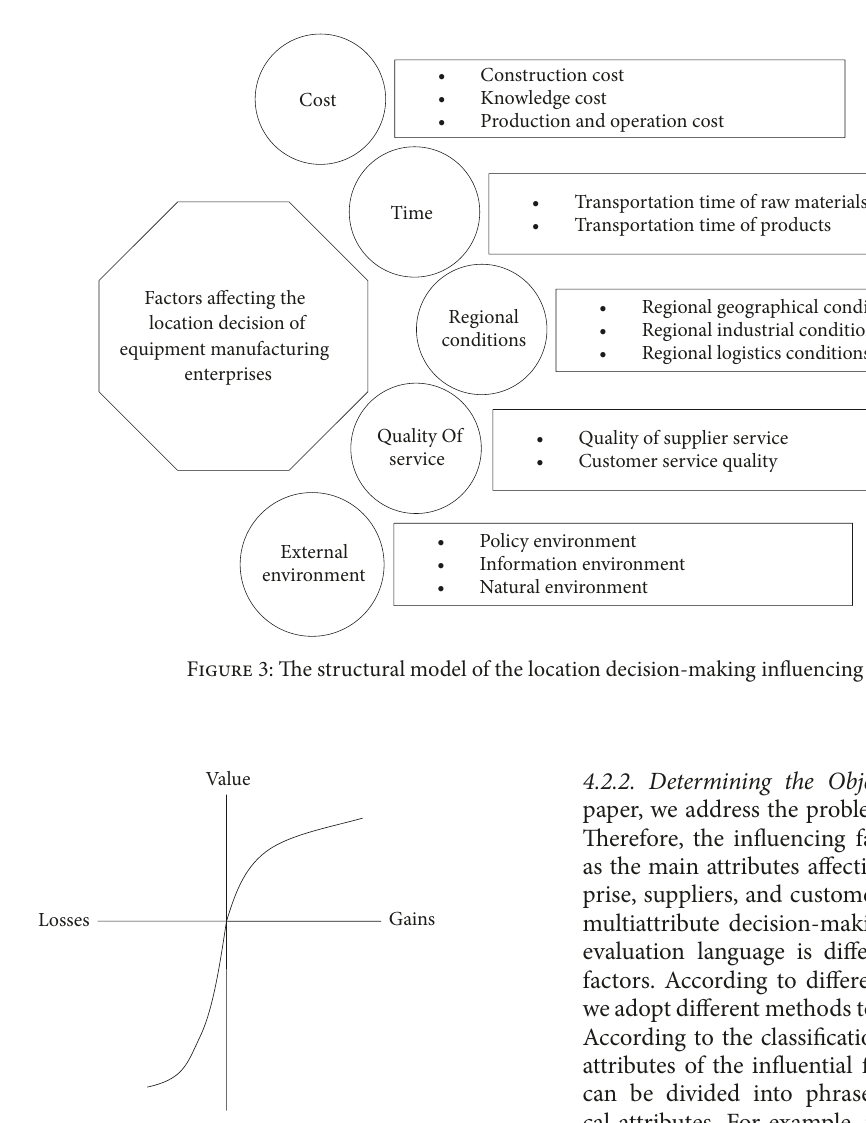
Figure 4: Value function